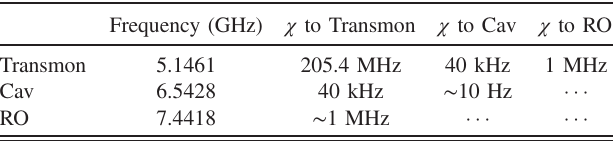
TABLE I. Hamiltonian parameters. Summary of the key system parameters. The nonlinearity of the cavity is below our meas- urement sensitivity and is extracted from a simulation of the system. RO, readout; Cav, cavity.